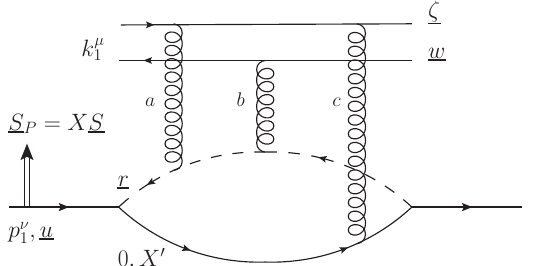
Figure 2: Diagram for the odderon exchange amplitude with the quark-diquark model of the proton, where all possible connections of the three gluons to the quark (solid line at the very bottom) and diquark (dashed line) and to the ζ , w dipole at the top should be summed over and the gluons are in the symmetric d abc color